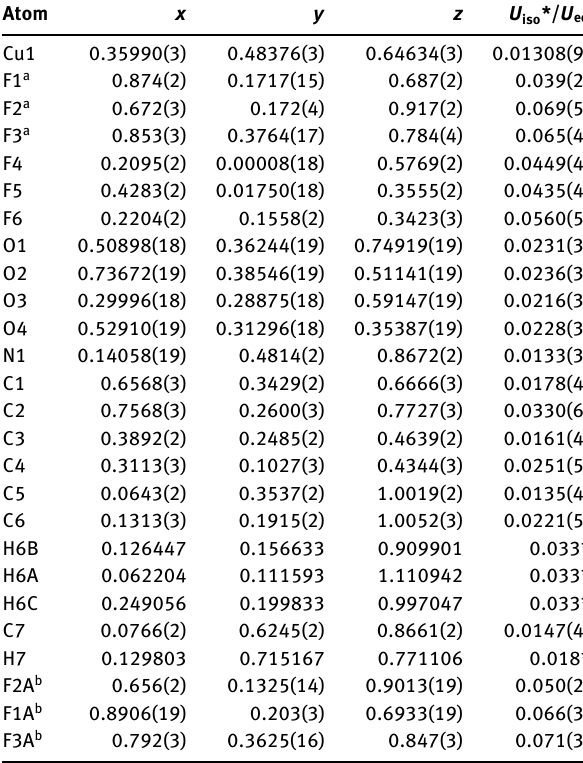
Table 2: Fractional atomic coordinates and isotropic or equivalent isotropic displacement parameters (Å 2 ). Atom x y